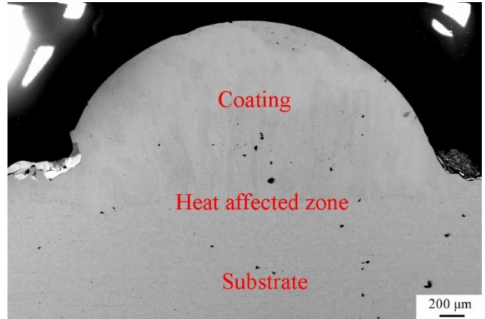
Figure 2. Photograph of cross-section of the laser-cladded 316L stainless steel modified using 2 wt % CeO 2 .